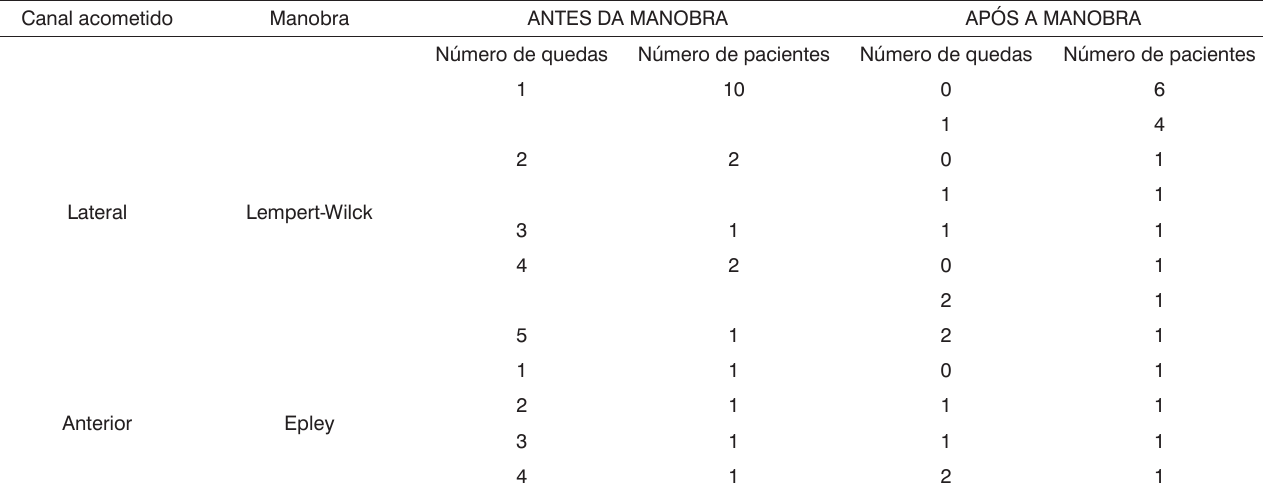
Tabela 4. Número de quedas antes e após o tratamento da Vertigem Posicional Paroxística Benigna em idosos por meio da manobra de Lem- pert-Wilck nos casos com acometimento do canal semicircular lateral (n=16) e da manobra de Epley, para o canal semicircular anterior